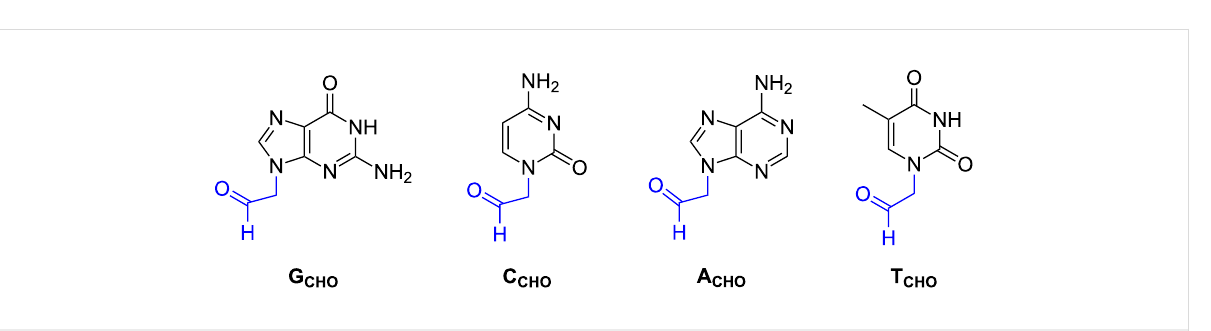
Figure 4 all possible products were eluted as a mixture separat- ed by anion exchange HPLC at 80 °C; under these